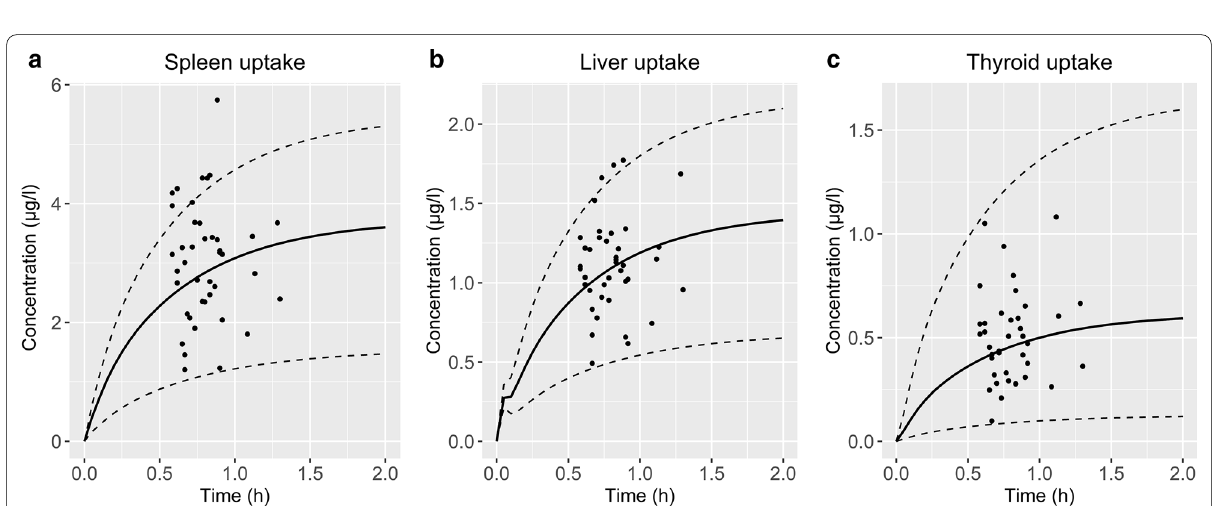
Fig. 4 Predicted 68 Ga‑DOTATATE concentration–time curves (solid lines) for spleen ( a ), liver ( b ) and thyroid ( c ). Ranges (dashed lines) are based on minima and maxima of administered peptide amounts (8.05 and 16.9 µg) and SSTR2